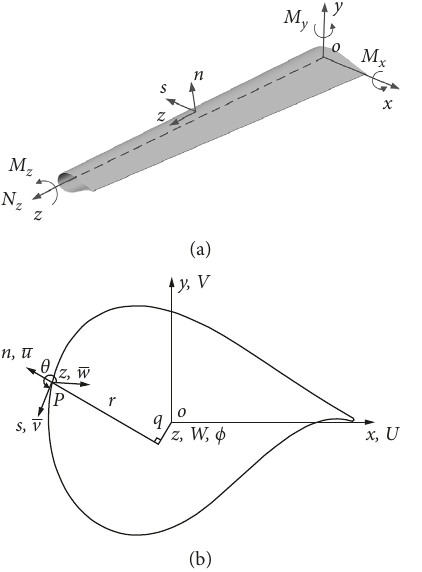
Figure 1: (a) Geometry and coordinate system of a tapered thin- walled rotor blade. (b) Sectional coordinates and